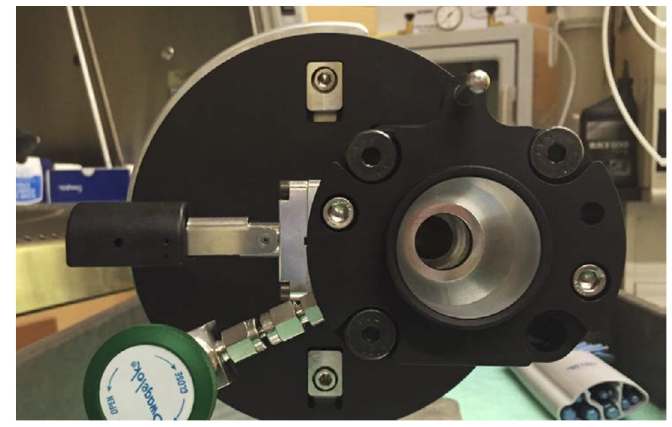
Figure 7. BN-131 target: ( a ) Isometric and ( b ) vertical mid-plane cross-section views.